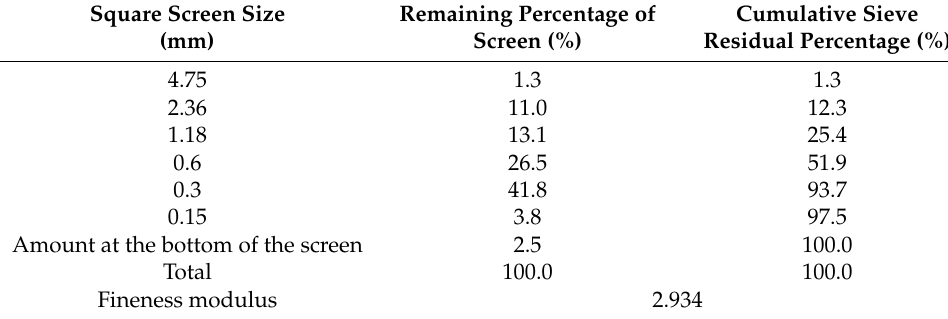
Table 2. Fineness modulus of sand.